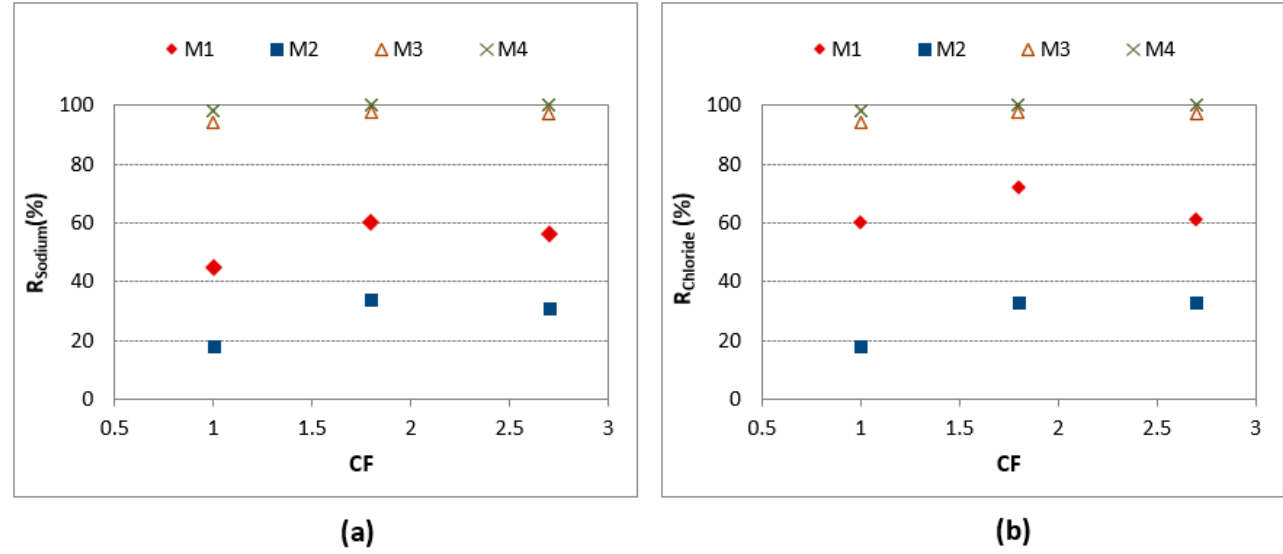
Figure 8. Influence of concentration factor (CF) on R Salt .